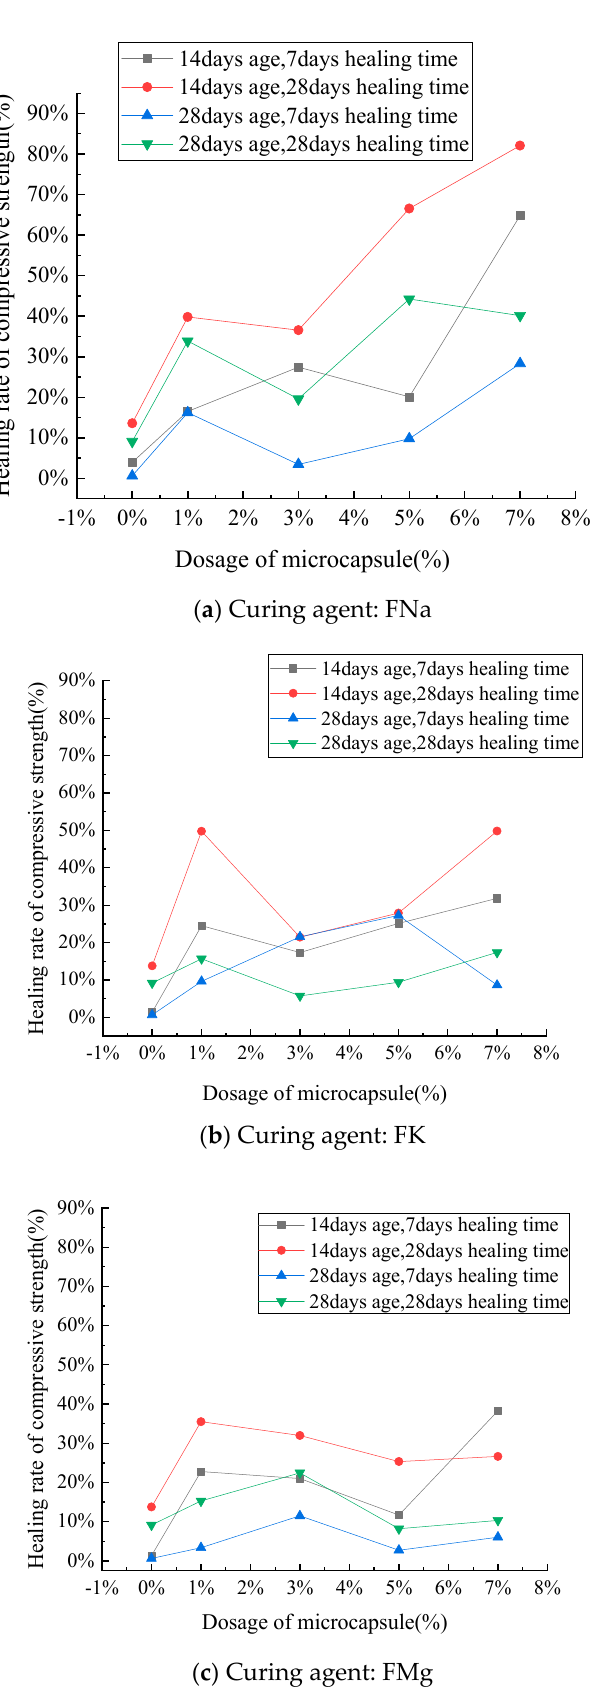
Figure 9. ( a – c ) The effects of healing time and age on healing rate.